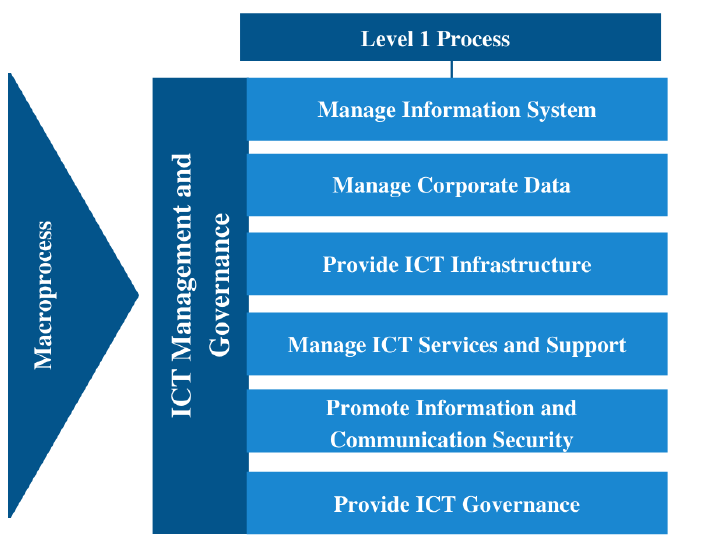
Figure 2. Level 1 process [41].